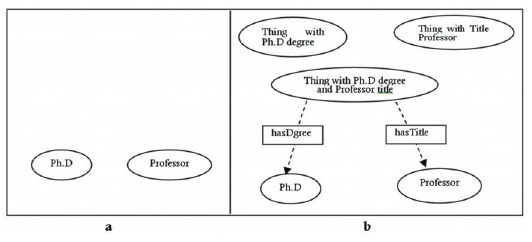
Fig. 3. Two kinds of graph-based ontology representations